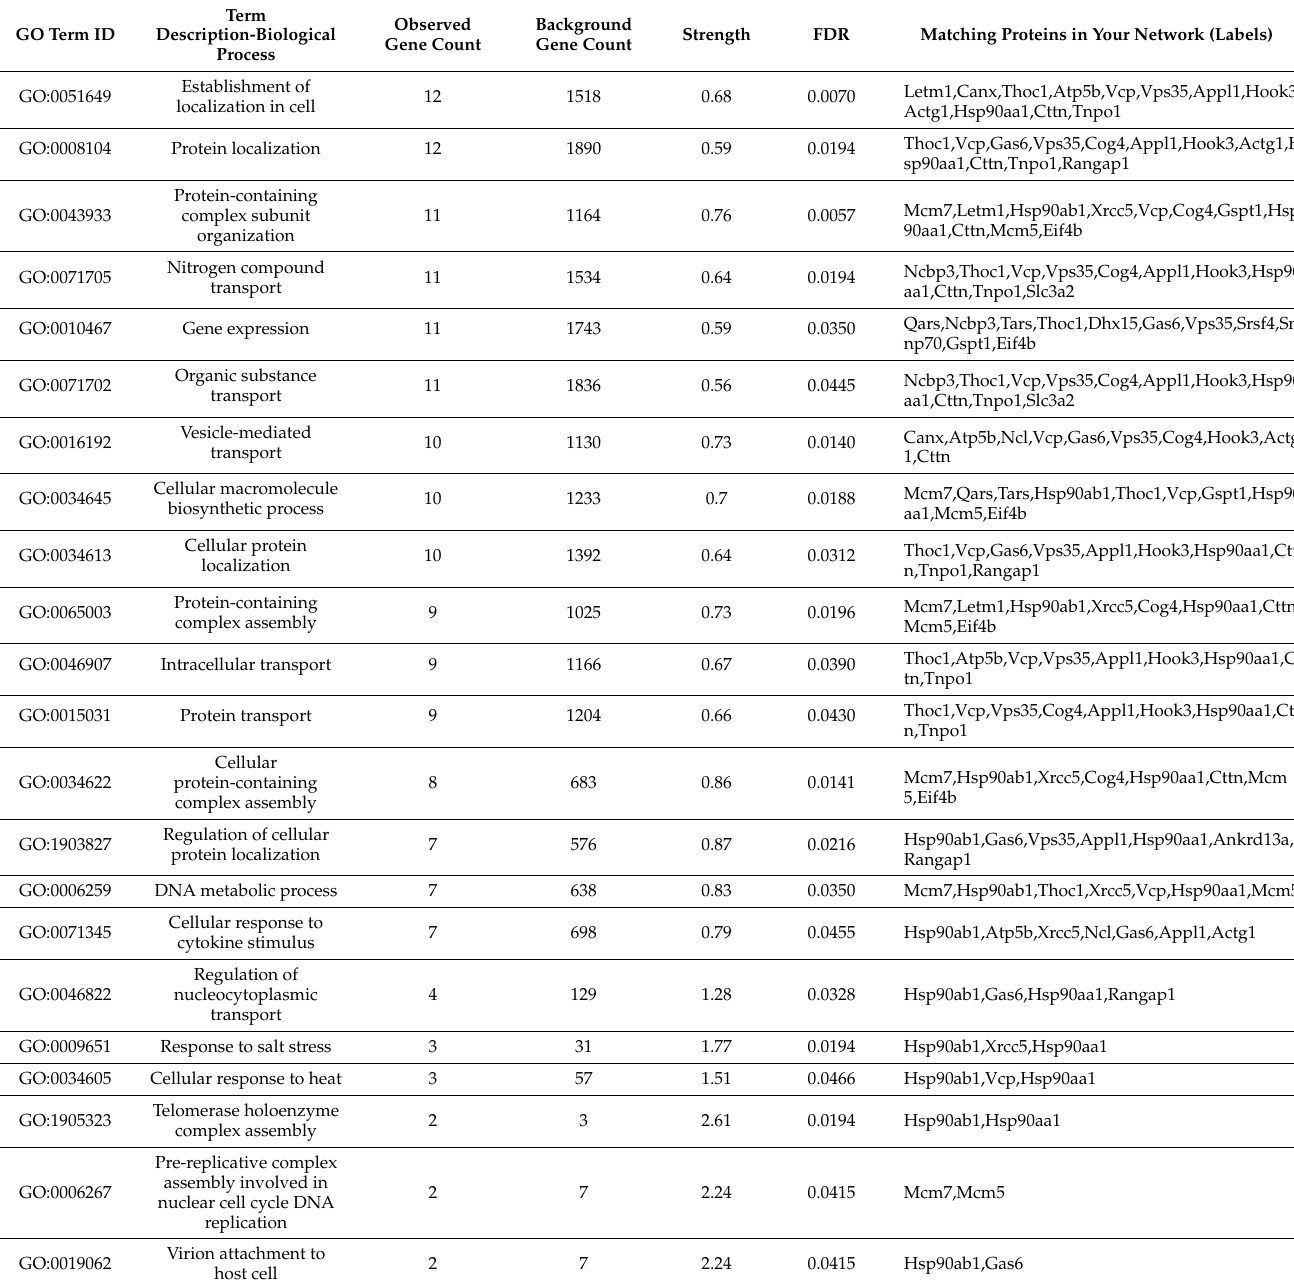
FDR = false discovery rate. Sample 1 correspond to the spots identified by white circles in Figure 3. Next, a Venn diagram was created to highlight the differences in the protein content between the four experimental conditions (DMSO, DMSO+OC, 8Br-cAMP, 8Br-cAMP+OC) for Sample 1. As shown in Figure 4B, protein content varied significantly between the four conditions. For instance, eight proteins were unique to the 8Br-cAMP+OC condition (identified by the letter G in Figure 4B and listed in column G of Table 3). On the other hand, other proteins were common to several conditions. For instance, two proteins were present in all four conditions (identified by the letter J in Figure 4B and in column J of Table